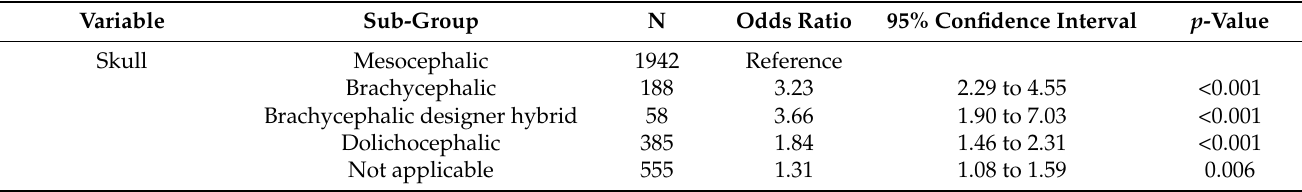
Table 7. Mitigation model 1, use of a coat in winter: canine variables tested through binary logistic regression for their association with coat use in winter to facilitate activity. Increased odds of coat use are indicated by an odds ratio greater than one, and an odds ratio lower than one indicates reduced odds of coat